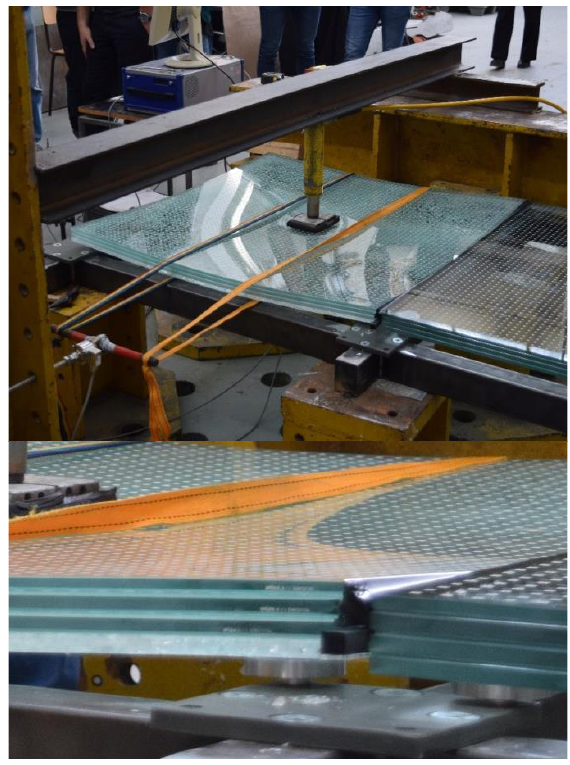
Fig. 8 Reached ultimate capacity of the pane by